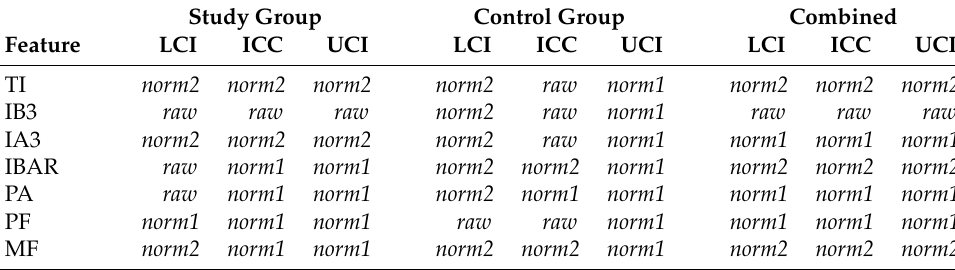
Table A4. Best normalization for intraclass correlation coefficients (ICC) based on Tables 1, A2, and